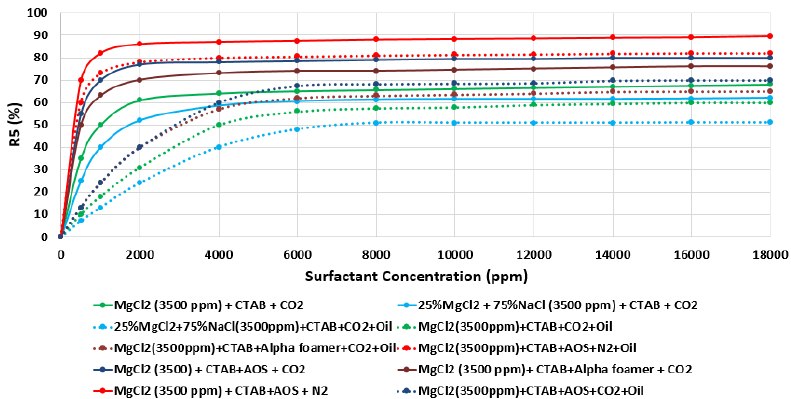
Figure 32. Variation of R5 (%) as function of surfactant concentration (ppm) of different tested surfactant (e.g., CTAB, AOS, and alpha-foamer) at various brine solutions in the presence of crude oil at (25 ◦